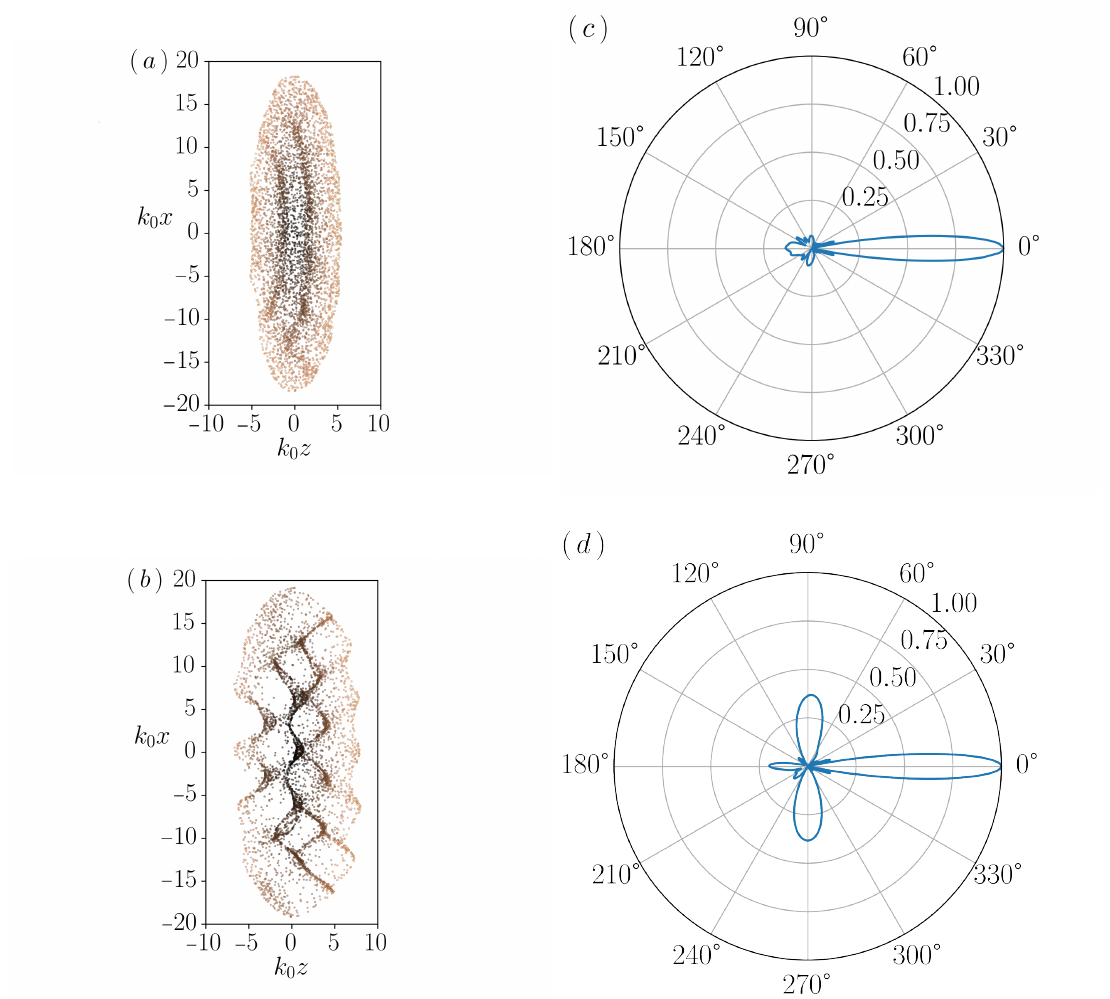
Figure 3. Collective scattering and pattern formation from an elliptical 2D atomic cloud irradiated with a pump field propagating perpendicular to its major axis and linearly polarized along the out-of-plane direction: ( a ) Shows the atomic density distribution of N = 5000, with an initial random distribution, at the time instant t = 0.120 ω − 1 r . ( b ) Depicts the density grating formation due to collective scattering at t = 0.239 ω − 1 r . The corresponding bunching factors | M ( k , t ) | for both time instants are displayed in ( c , d ),